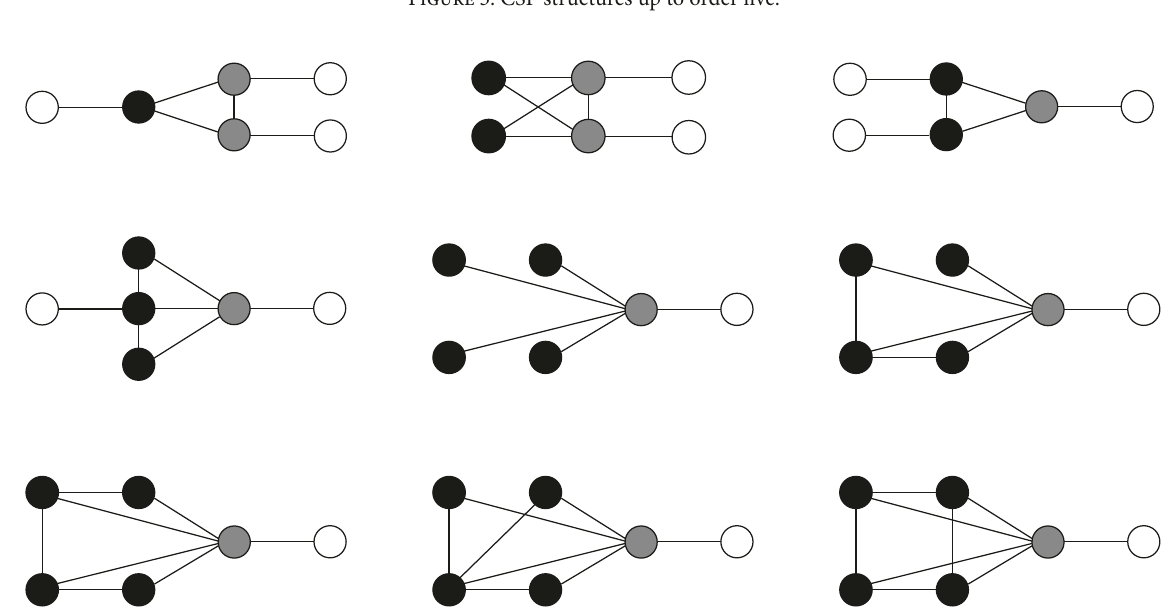
Figure 4: CSP structures in order